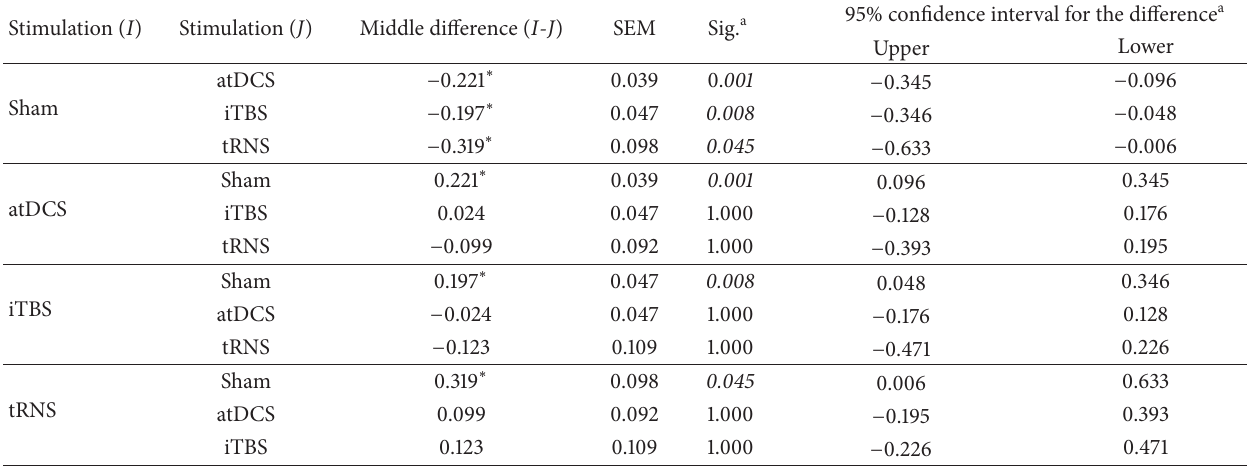
Table 1: Results of the repeated measurement